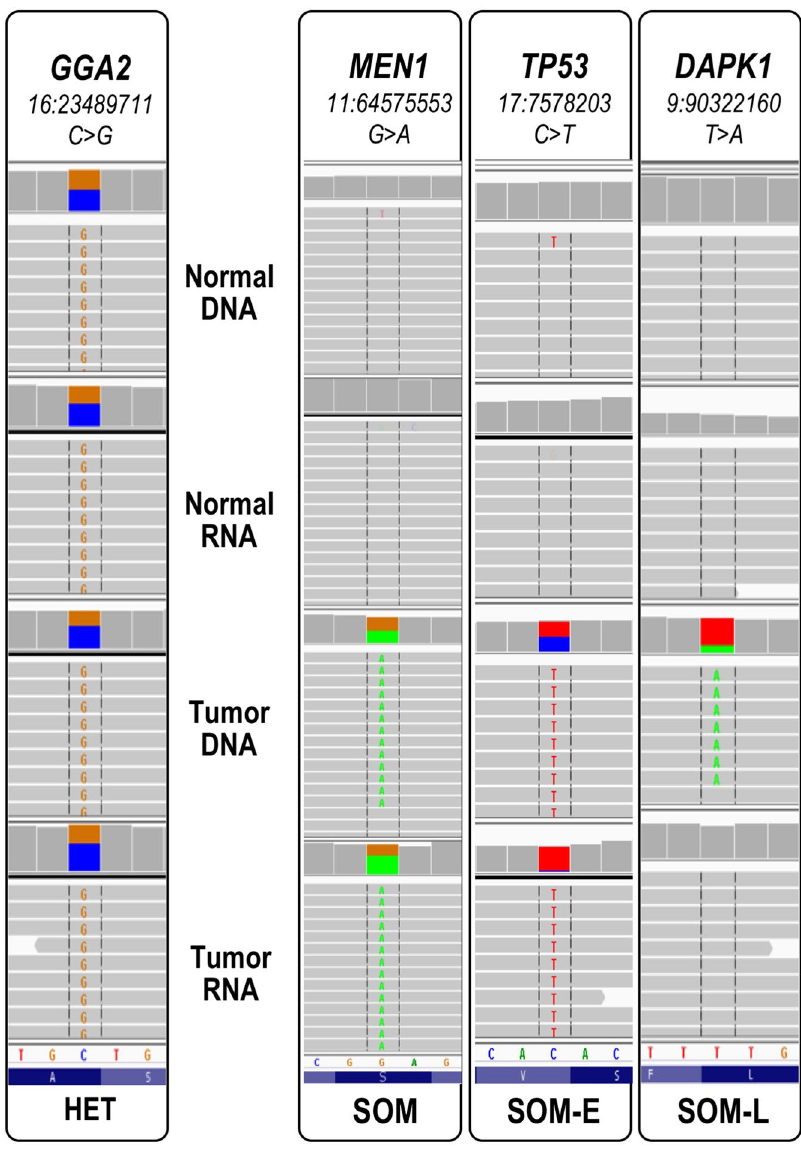
Figure 2. IGV visualization of somatic mutations that are over-expressed (SOM-E, middle) or under-expressed (SOM-L, right) compared to expected allele distribution for a germline heterozygote variant (left); the heterozygosity is reflected through color-coding of the summary flag on the top of each panel. The gray lines represent reads, and the colored letters show differences from the